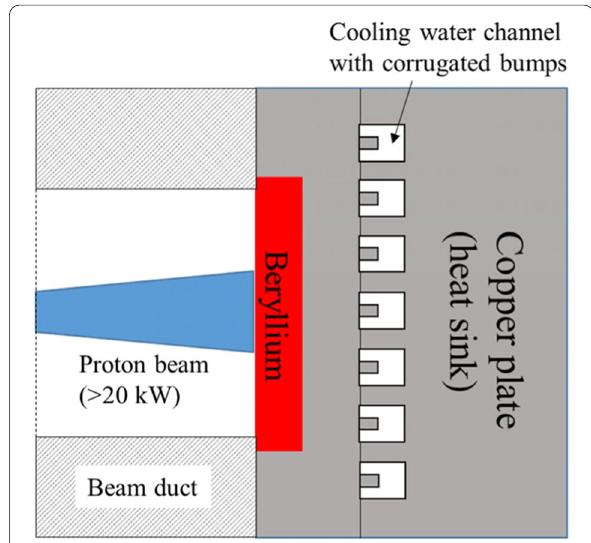
Fig. 14 Schematic drawing of the current beryllium target assembly for the DM